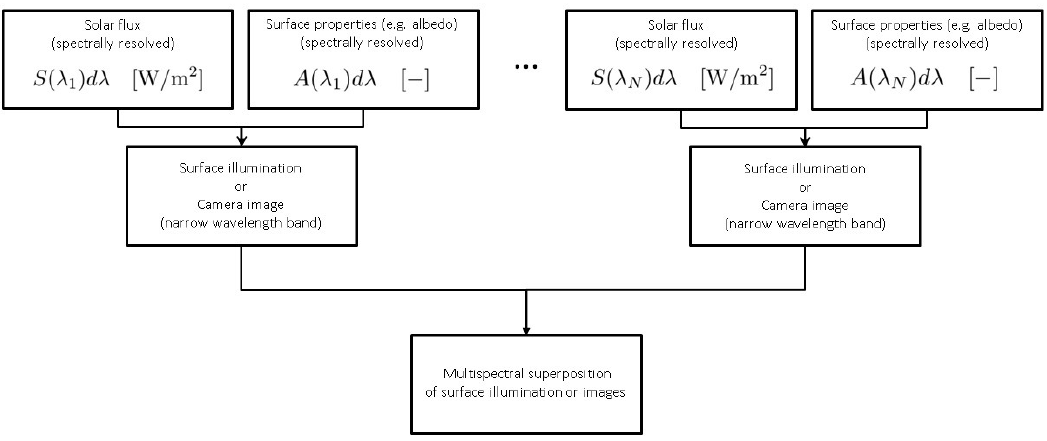
Figure 4. Multispectral superposition of surface illumination or camera images. Surface illumination levels or camera images are calculated for N wavelengths, respectively, wavelength bands (or arbitrary width) and then added. This approach is numerically more expensive but yields more accurate results.